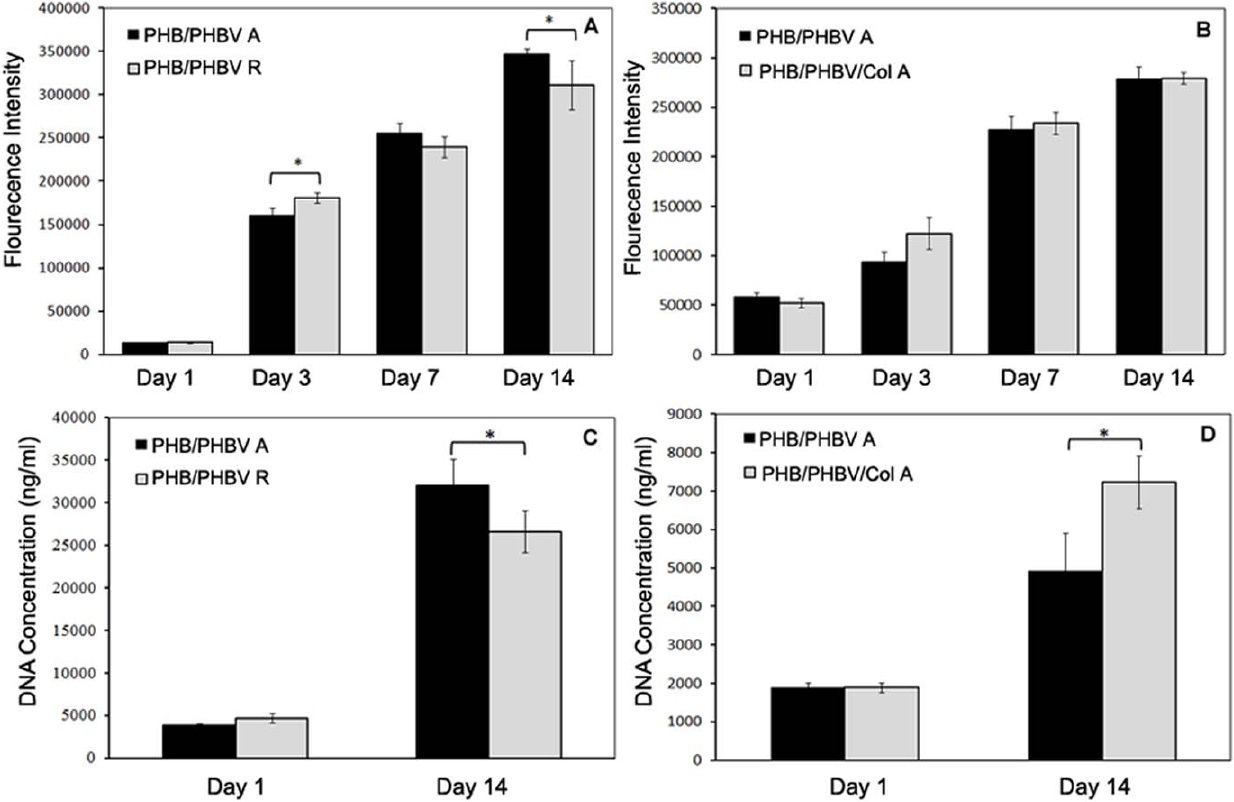
Figure 8. Alamar blue and DNA quantification assay results to compare metabolic activity and proliferation of SCs. (A, C) PHB(50)/ PHBV(50) random nanofibers (PHB/PHBV R group) and PHB(50)/PHBV(50) aligned nanofibers (PHB/PHBV A group); (B, D) PHB(50)/PHBV(50) aligned nanofibers (PHB/PHBV A group) and PHB(45)/PHBV(45)/collagen(10) aligned nanofibers (PHB/PHBV/Col group) during 14 days of culture. Asterisks represent significant difference at p # 0.05.